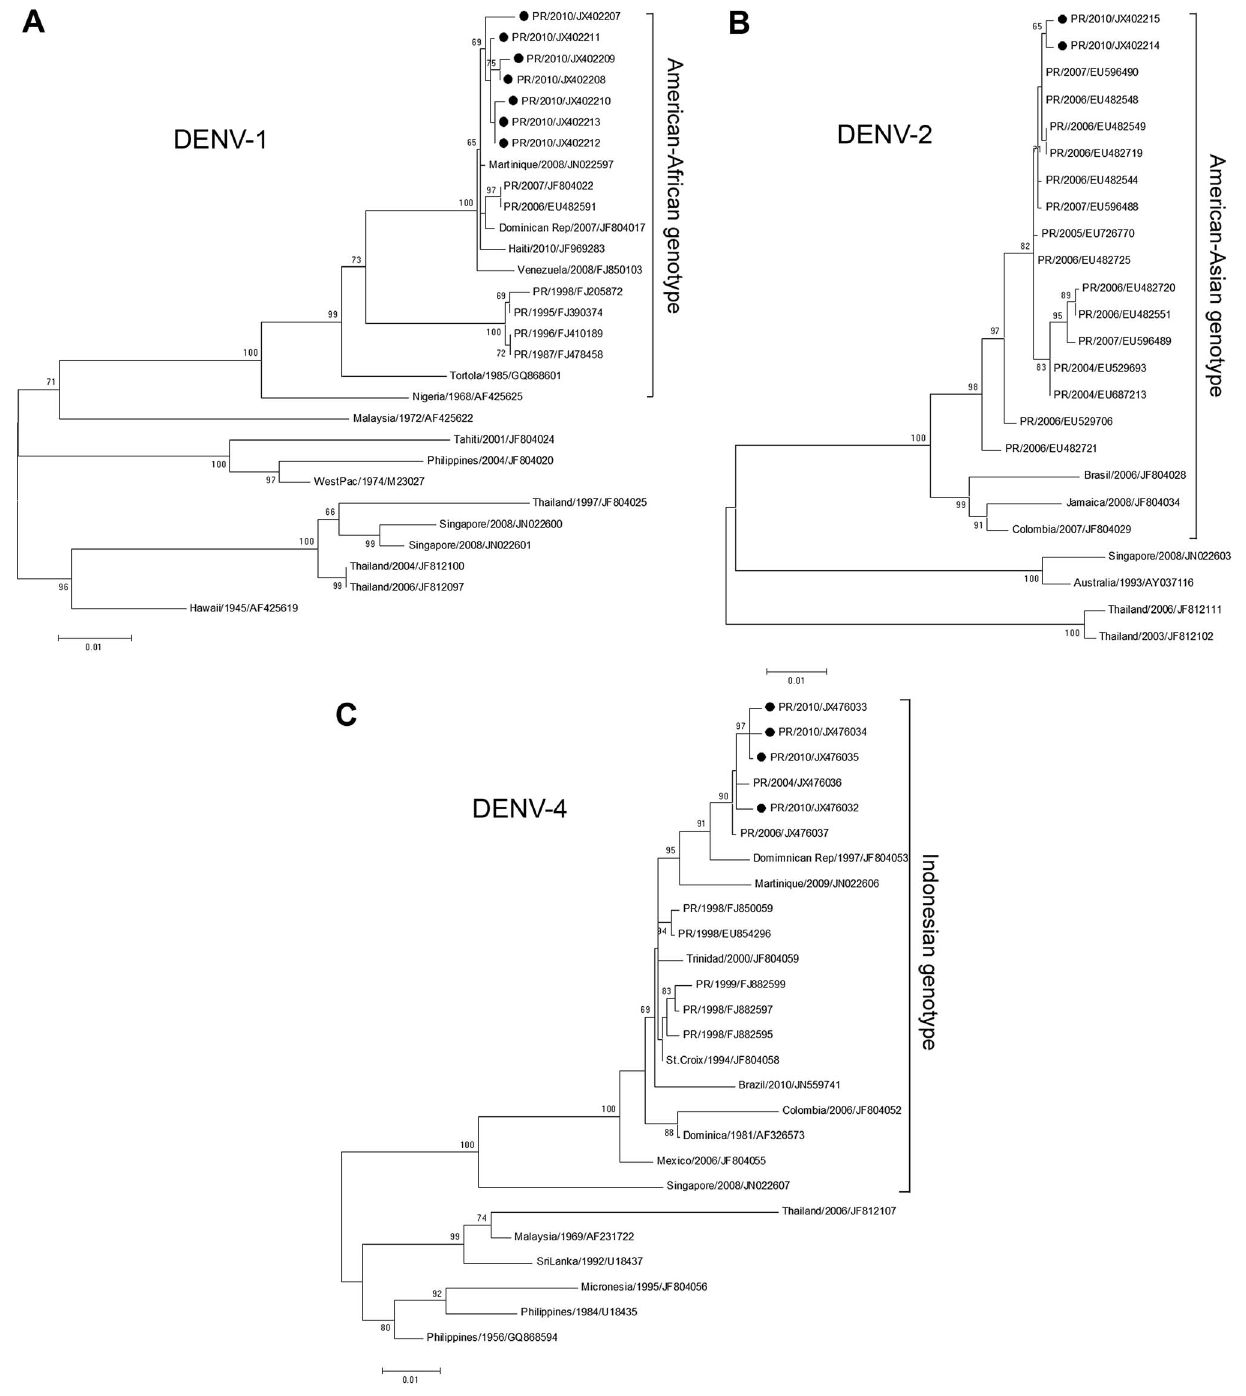
Figure 4. Maximum likelihood trees depicting the phylogenetic relationships of DENV-1, -2, and -4 isolated in Puerto Rico, 2010. Each phylogeny was tested with 1,000 bootstrapping cycles. Each taxa label consists of country of origin (PR=Puerto Rico), year of virus isolation, and GenBank accession number. Viruses isolated and sequenced for this investigation are labeled with a black dot. Genotype names were based on previously published phylogenies [32,33]. All outgroups have been removed. A : Phylogenies were constructed using 29 DENV-1 E gene sequences: seven from Puerto Rico in 2010, and 22 obtained from GenBank to represent the three main genotypes: American-African, South Pacific, and Asian. B : Phylogenies were constructed using 24 DENV-2 E gene sequences: two from Puerto Rico in 2010, and 22 obtained from GenBank to represent the three main genotypes: American-Asian, Cosmopolitan, and Asian II. C : Phylogenies were constructed using 26 DENV-4 E gene sequences: four from Puerto Rico in 2010, and 22 obtained from GenBank to represent the two main genotypes: Indonesian and South East Asian.